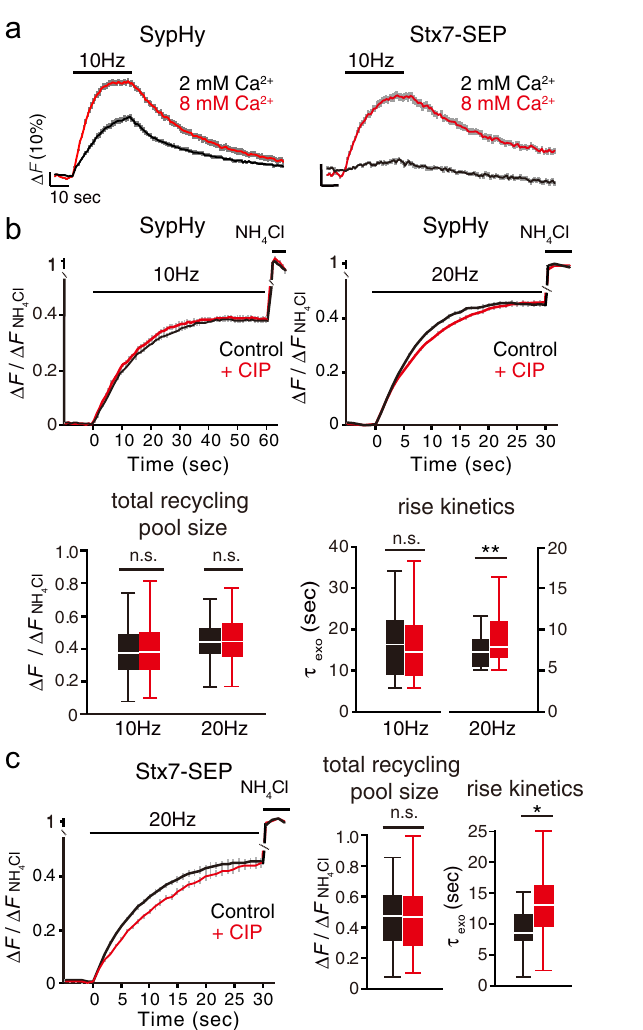
Fig. 4 Fast recruitment of Stx7-vesicles is mediated by activation of the Ca 2 + /calmodulin pathway. a Responses of Stx7-SEP (right) in the presence of normal (2 mM, black) and high (8 mM, red) external Ca 2 + . For comparison, responses of SypHy under identical conditions are shown in the left panel. b Effects of CIP (red) on exocytosis of total recycling pool monitored by SypHy. Responses at 10 Hz, 600APs (left) and 20 Hz, 600APs (right) with ba fi lomycin treatment are shown. Control experiments without CIP in respective conditions are shown in black. Bottom box- whisker plots show quantitative comparisons of total recycling pool sizes and rise kinetics. Normalized fl uorescence peaks (left) or the time constants of rise time ( τ exo ) (right) during 10 Hz or 20 Hz stimulation are compared. c Effects of CIP (red) on exocytosis of the total recycling pool monitored by Stx7-SEP. Responses at 20 Hz, 600APs (left) with ba fi lomycin treatment are shown. Control experiments without CIP in the respective conditions are shown in black. Right box-whisker plots show quantitative comparisons of total recycling pool sizes and rise kinetics. Normalized fl uorescence peaks (left) or the time constants of rise time ( τ exo ) (right) during 20 Hz stimulation are compared. All traces are average traces from >150 boutons.